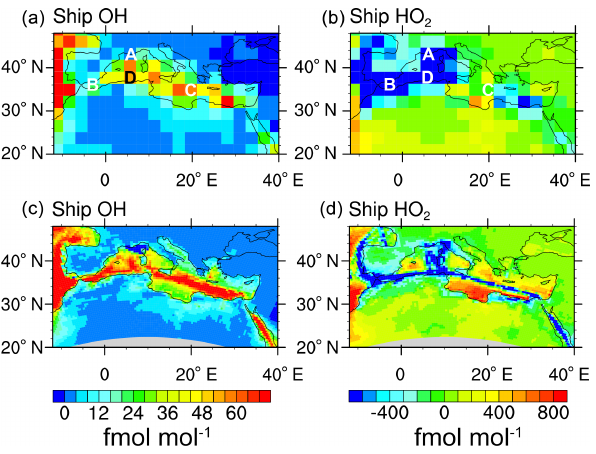
Figure 6. Absolute contribution of shipping to the simulated OH (a, c) and HO 2 (b, d) volume mixing ratios (in fmolmol − 1 ) for August 2007. (a, b) EMAC; (c, d) MECO( n ). Regions A–D are characterised by different chemical situations. A: southern France; B: Strait of Gibraltar; C: central Mediterranean Sea; D: Tunesian coast; see text for more details.